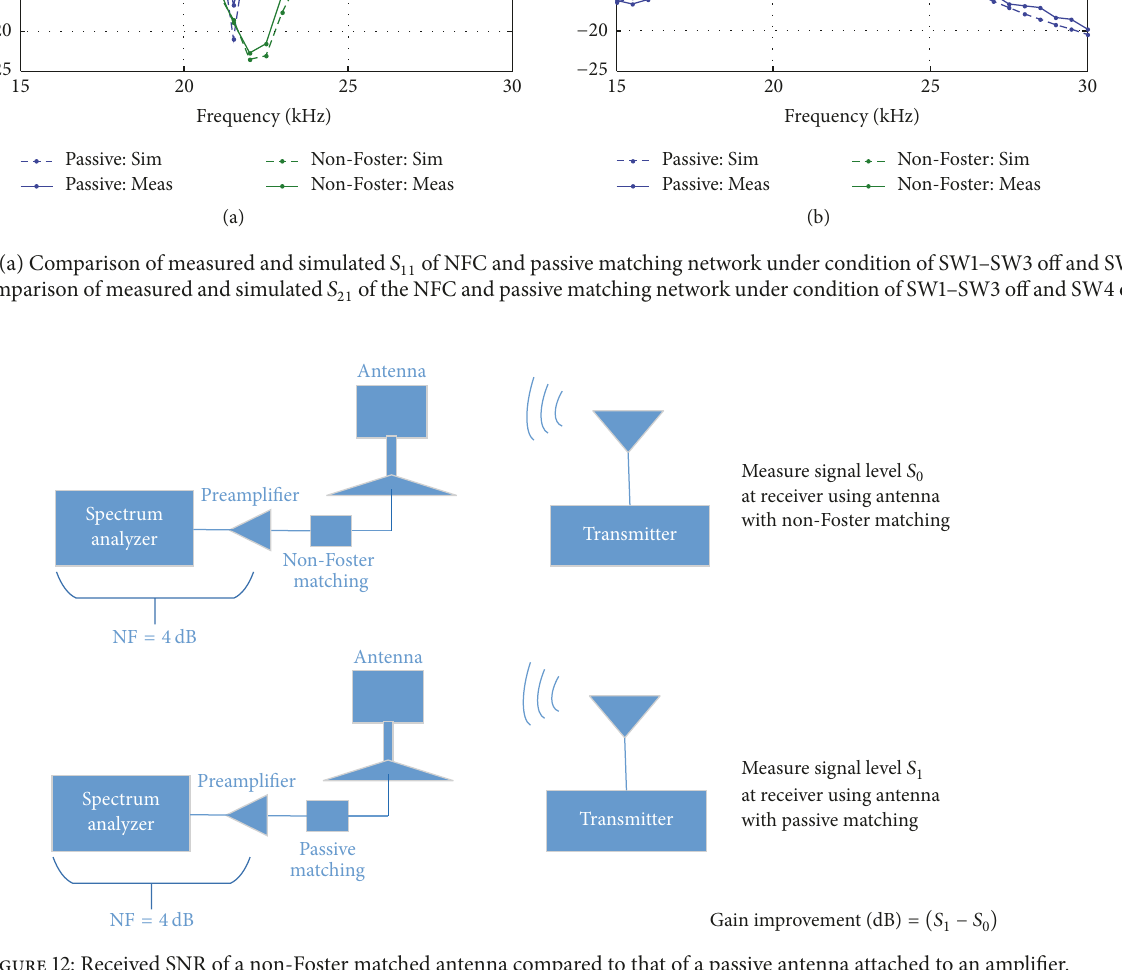
test in VLF, the Tx and Rx system test distance should be much further compared to the test in HF. The received signal is transmitted from a VLF transmitting